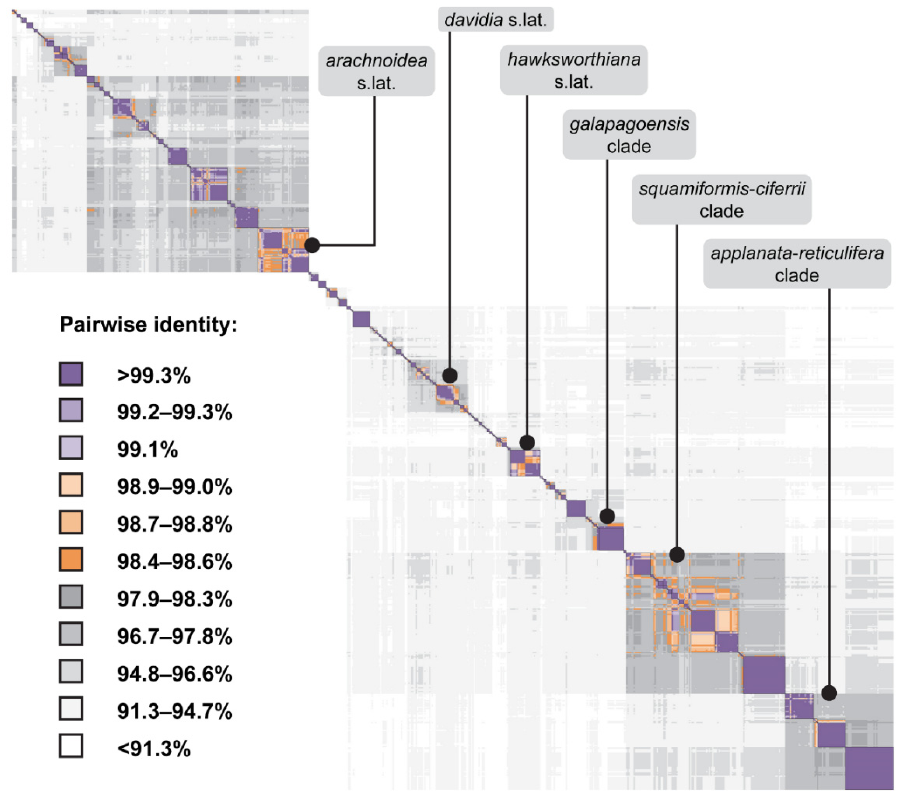
Figure 7. Barcoding gap analysis using DNADIST in BioEdit. The different colors represent pairwise identity percentages (see legend). Highlighted clades show instances where the DNADIST and the ad hoc approaches inferred different species delimitations, potentially over- or underestimating species